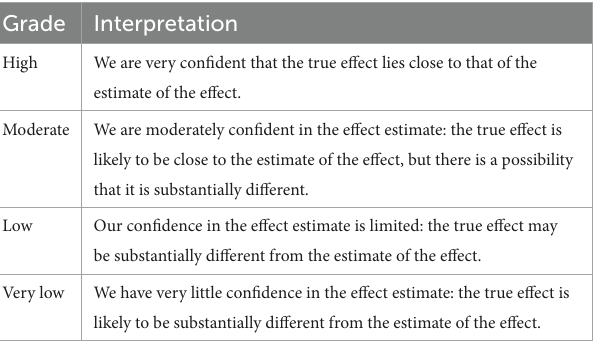
TABLE 1 Strength of evidence grades and interpretations